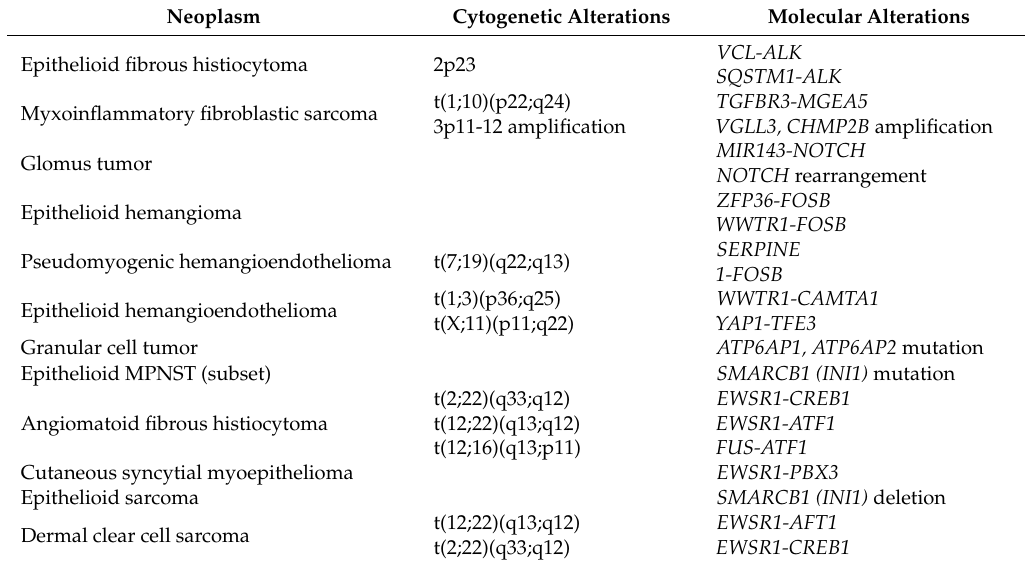
Recently identified cytogenetic and molecular alterations in cutaneous epithelioid mesenchymal